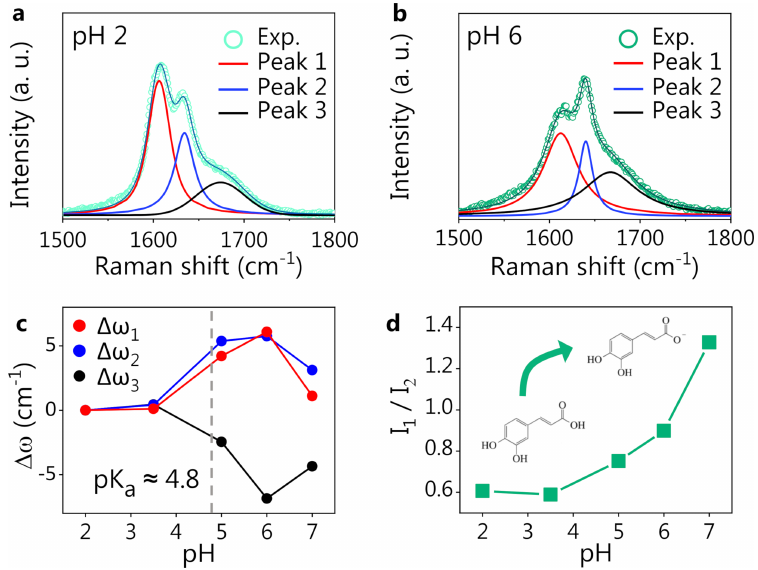
Figure 2. CA response to pH. Fitting deconvolution of the three most prominent peaks in the Raman spectrum of CA at pH 2 ( a ) and at pH 6 ( b ). The thick solid lines are the Voigt fitting components, and the thin solid line is the cumulative fitting, nicely reproducing the experimental data (dots). ( c ) Spectral shift of the peak position ( ∆ ω = ω pH − ω pH = 2 ) for three fitting components as a function of pH. ( d ) Intensity ratio of the two strongest CA peaks (1 and 2) vs.